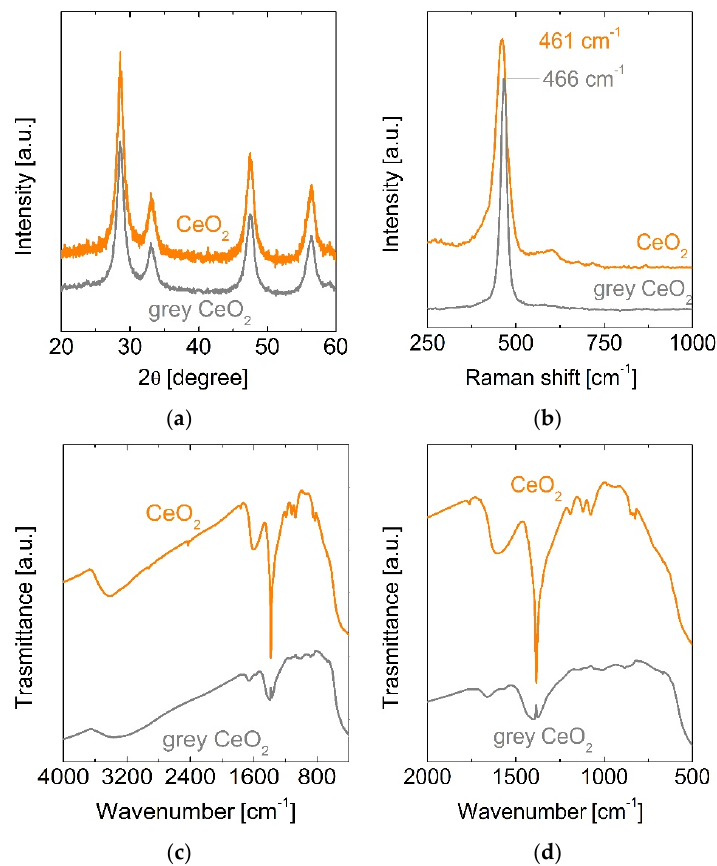
Figure 2. ( a ) XRD patterns, ( b ) Raman spectra, ( c ) FTIR spectra of the synthetized samples, and ( d ) FTIR zoom of the “carbonate”